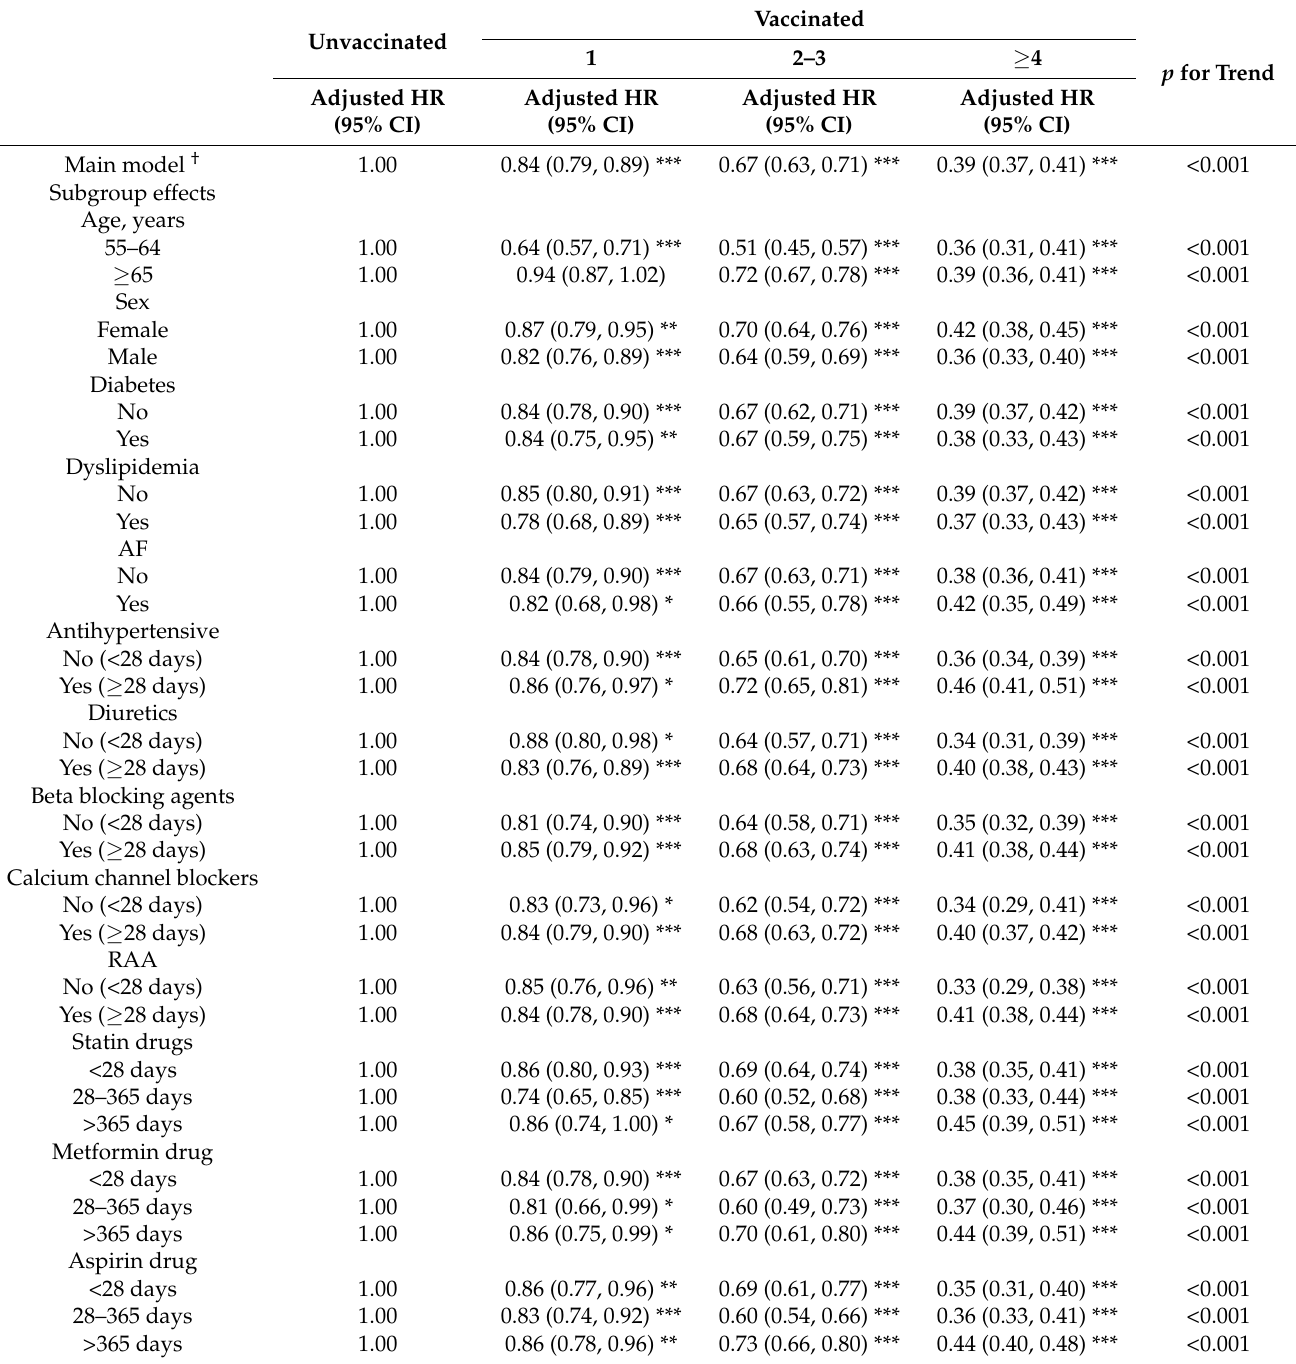
Table 5. Sensitivity Analysis of Adjusted HRs of Vaccination in the Risk Reduction of All Strokes in All Seasons.